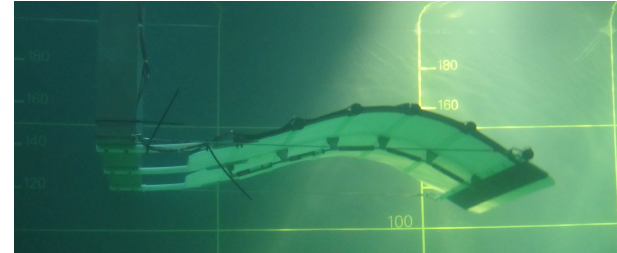
Fig. 5. Picture of the 1/20 th scale prototype during experiments